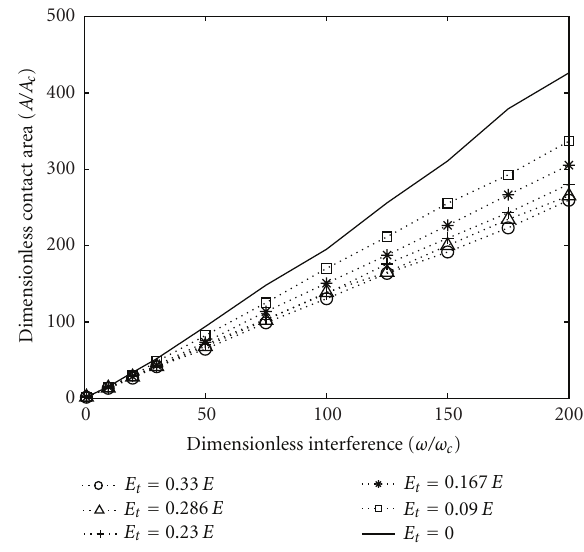
Figure 6: Dimensionless contact area versus dimensionless inter- ference for stick contact